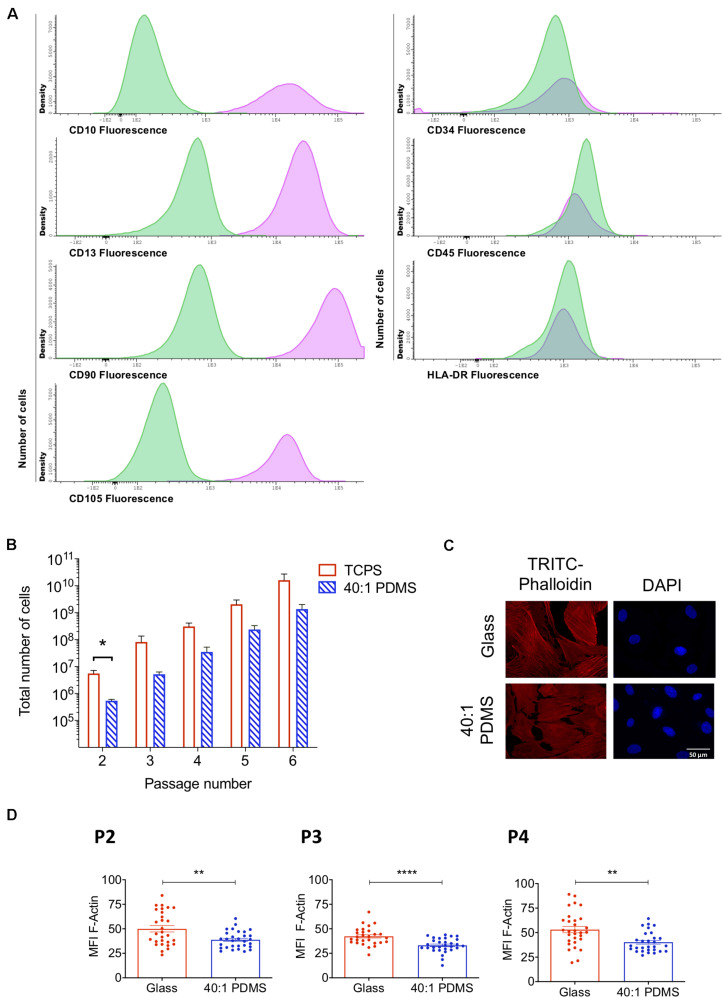
hUCM-MSCs can proliferate on and respond to mechanical cues provided by a soft PDMS substrate. (A) Immunophenotypic characterisation of hUCM-MSCs (average of four independent samples at P4). Cells were labelled with antibodies against the indicated antigens and analysed by flow cytometry. In parallel, unlabelled hUCM-MSCs were also acquired in the flow cytometer as negative controls. In the histograms, y-axis represents the number of cells (density); and x-axis represents the amount of protein expressed per cell, measured as mean fluorescence intensity (MFI). Labelled hUCM-MSCs are represented as pink lines, whereas green lines correspond to unlabelled hUCM-MSCs (negative control). hUCM-MSCs were positive for CD10, CD13, CD90, and CD105, and negative for CD34, CD45 and HLA-DR. (B) Total number of cells calculated for hUCM-MSCs on each passage (P2–P6) in culture on TCPS or 40:1 PDMS (as indicated). Bars represent mean ± SEM of at least three independent experiments using cells obtained from different donors. Statistical analysis was performed using the non-parametric Mann–Whitney test with significant differences indicated as *p < 0.05. (C) Representative fluorescence microscopy images and (D), respective MFI of F-actin of hUCM-MSCs cultured on stiff or soft 40:1 PDMS substrates from P2 to P4 (as indicated). At each of the indicated passages, cells were seeded on stiff glass coverslips or soft 40:1 PDMS substrates for 48 h and then fixed and stained with TRITC-Phalloidin (to stain F-actin, in red) and DAPI (to counterstain nuclei, in blue). Bars represent mean ± SEM of three independent experiments. Statistical analysis was performed using a two-tailed Student’s t-test with significant differences indicated as **p < 0.01 and ****p < 0.0001.